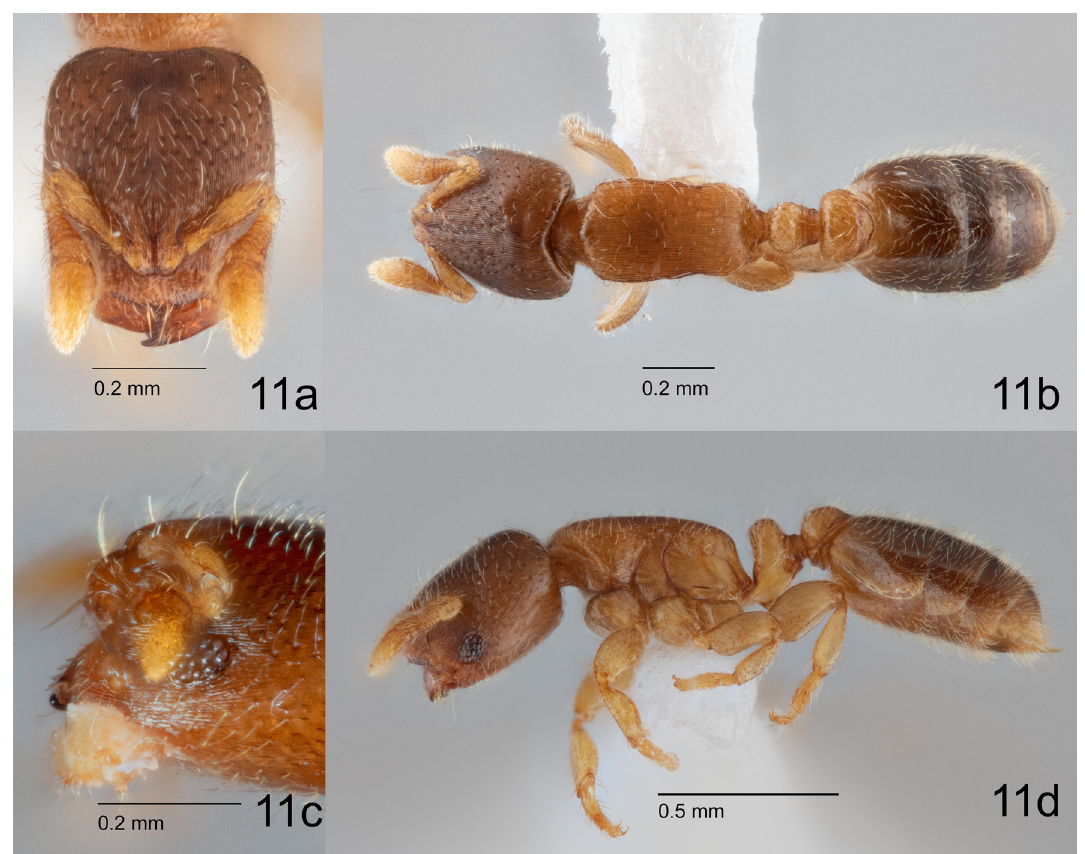
Fig. 11. Rhopalomastix parva Wang & Jaitrong sp. nov., paratype, worker (ZRC_ENT00013948). a . Head in full-face view. b . Body in dorsal view. c . Close-up of clypeus in profile. d . Body in lateral